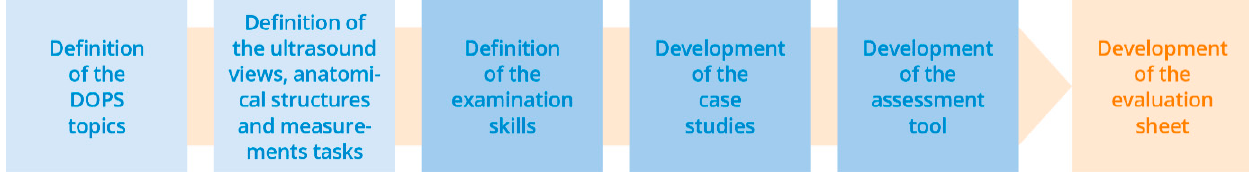
Figure 1. Development steps involved in establishing and evaluating direct observation of procedural skills (DOPS) tests in head and neck ultrasonography.